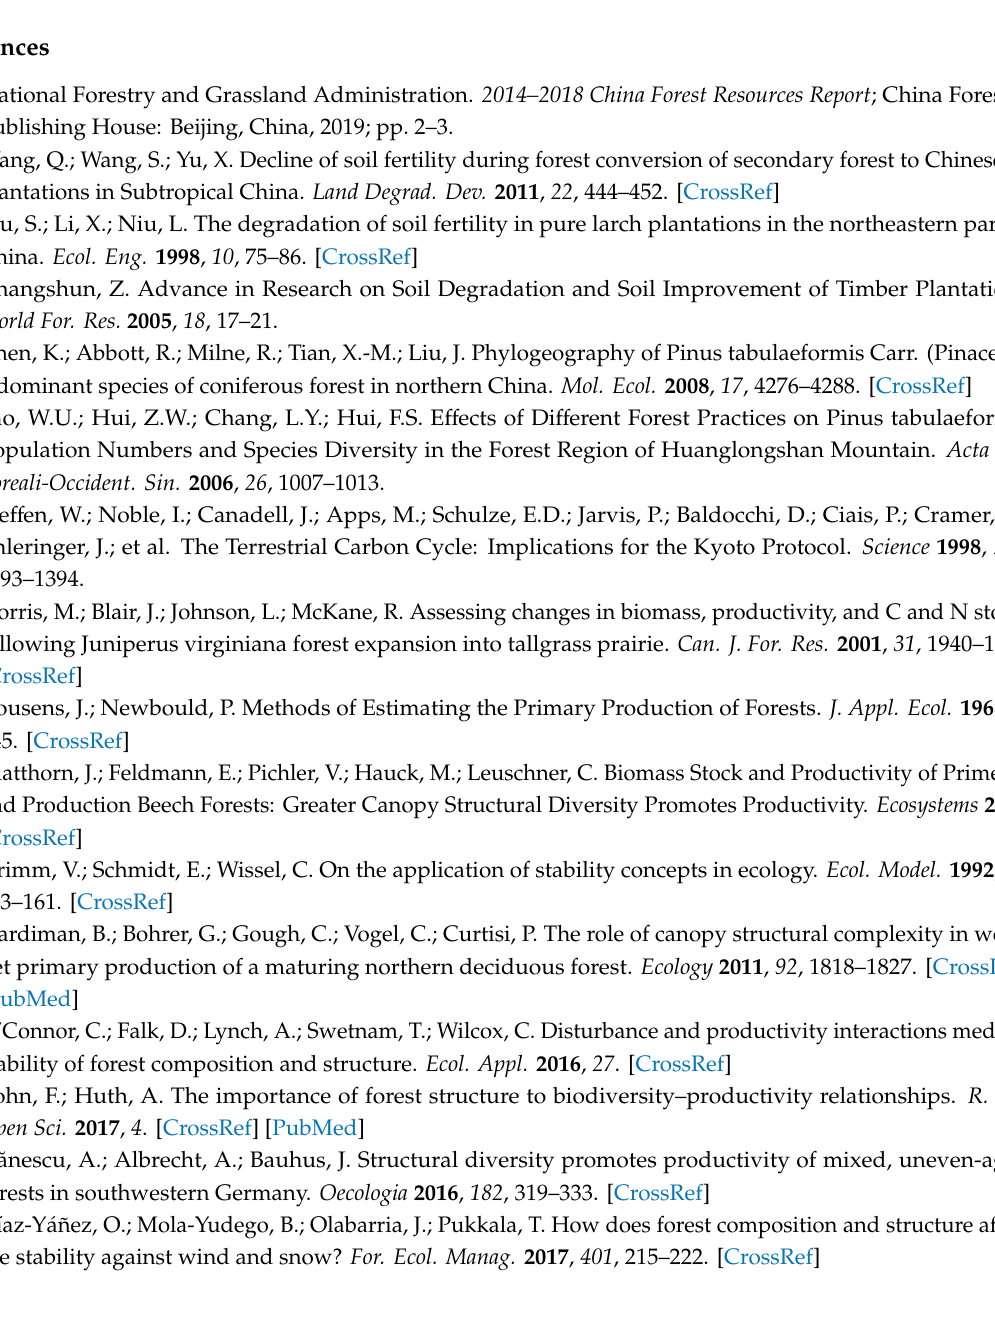
Table S1: The original results of the 23